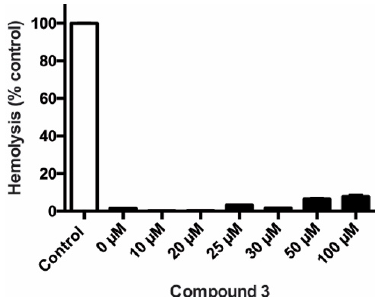
Figure 6. Hemolytic properties of GAEL 3 using freshly isolated ovine erythrocytes. 1% ammonium hydroxide was used for 100% hemolysis, the control. The values were determined as % of control.